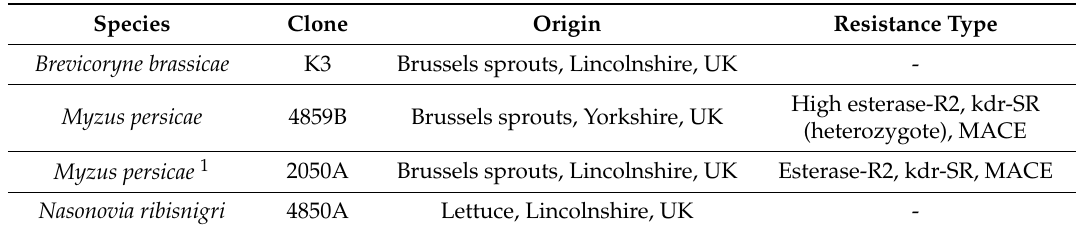
Table 1. Aphid clones used in this